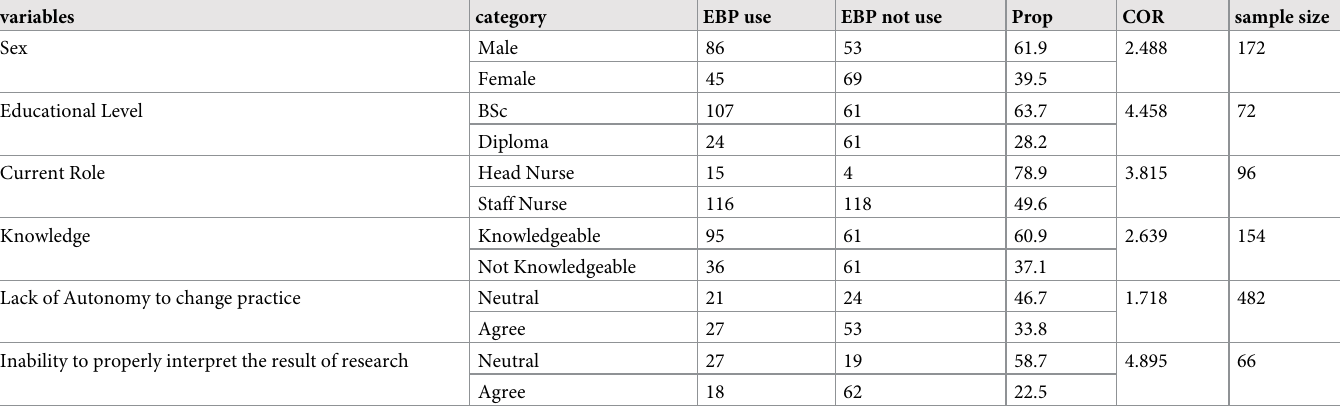
Table 1. A calculated sample size of EBP by Epi Info of each factor variable from the previous cross-sectional study. variables